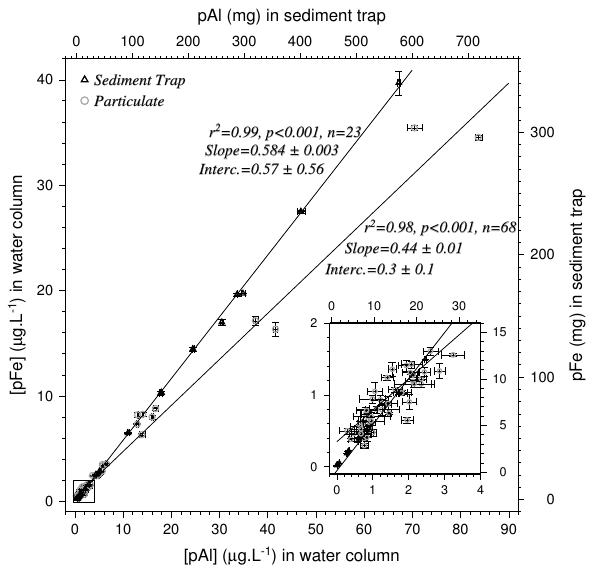
Fig. 3. [pFe] versus [pAl] in sediment trap and in the water colum. Black triangles (Right and top axes) are for sediment trap data, in mg. Open circles (Left and bottom axes) are for particulate in the water column, in µgL − 1 . Both sets of axis are proportional.